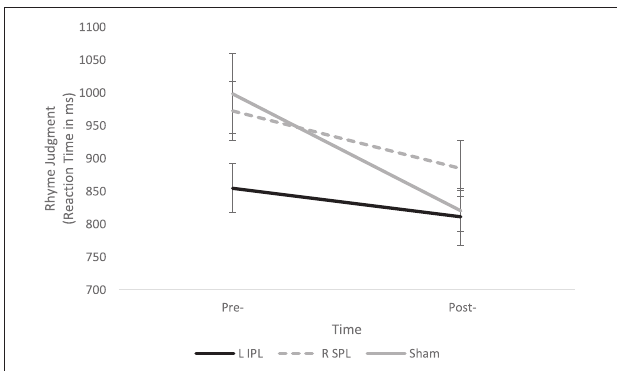
FIGURE 2 | Change in Rhyme Judgment performance pre- and post-stimulation for each group. A significant Group × Time interaction indicates the Sham group showed significantly greater improvement than the L IPL and R SPL groups. Error bars indicate one standard deviation.